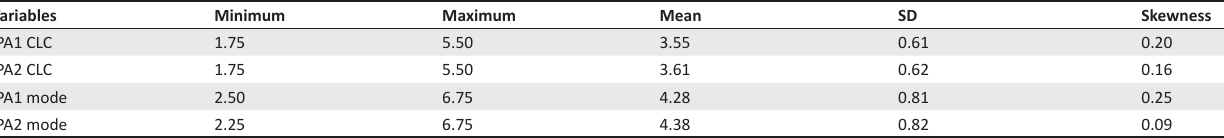
TABLE 2: Descriptive statistics. Variables